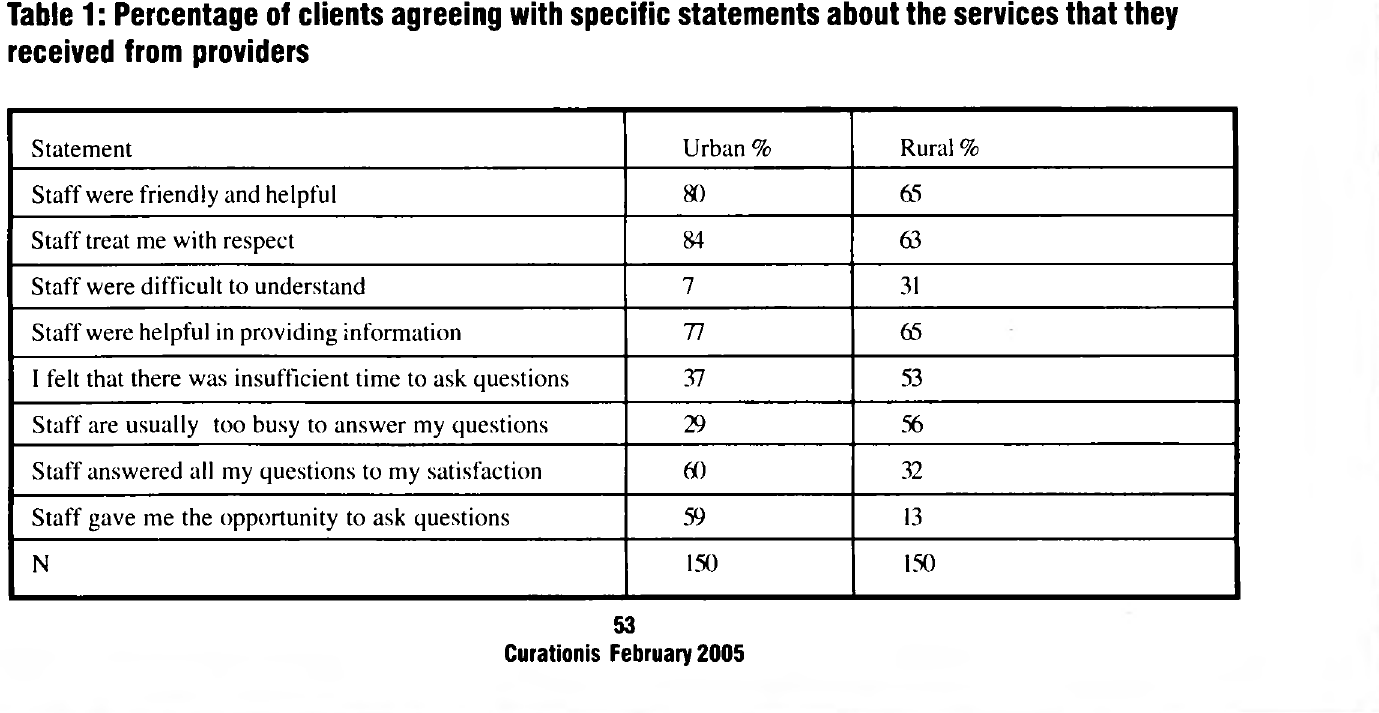
Table 1 : Percentage of clients agreeing with specific statements about the services that they received from